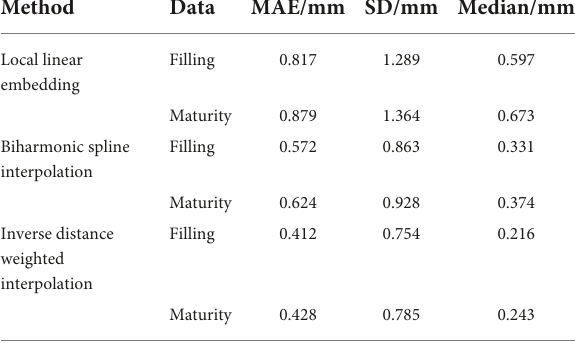
TABLE 2 Error indicators based on different interpolation